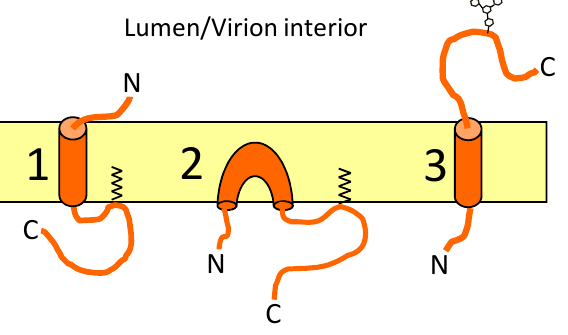
Figure 4. Topologies of the CoV E protein. The three proposed topologies of CoV E. (1) shows a type III membrane protein; (2) shows a membrane hairpin; and (3) shows a type II membrane protein with a putative N-linked oligosaccharide.